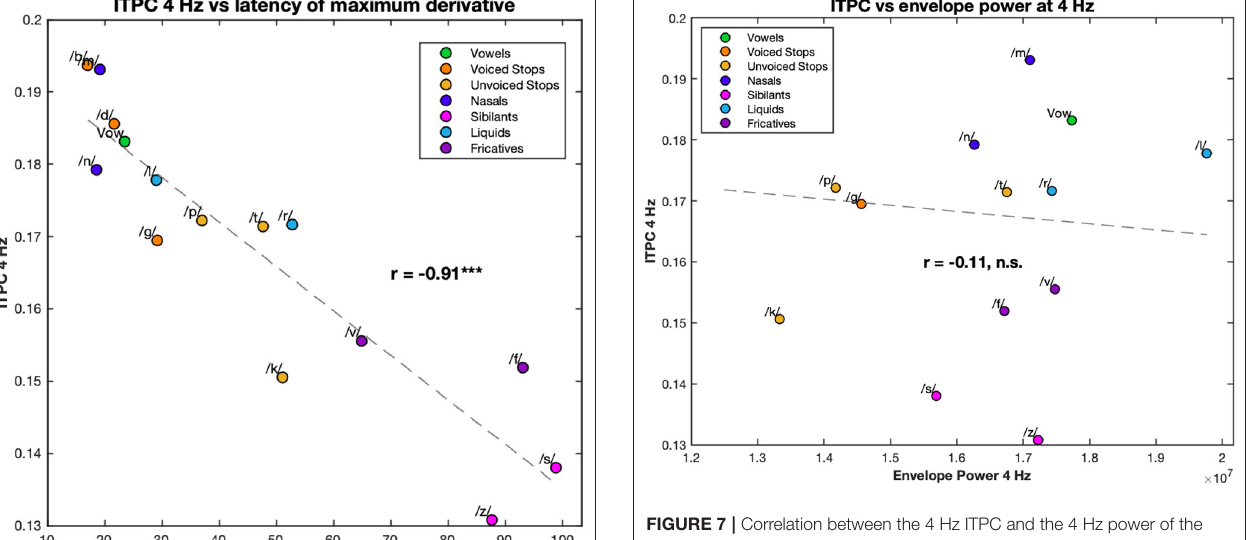
FIGURE 7 | Correlation between the 4 Hz ITPC and the 4 Hz power of the stimulus envelopes. The EEG ITPC at 4 Hz is plotted against the power of the envelope of each stream. Both are averaged over condition. Each color corresponds to a different condition (see legend). Dashed line represents the line of best fit (least means squares). The correlation coefficient is given below this line. n.s., not significant. also closely aligned in time with the peaks of syllable